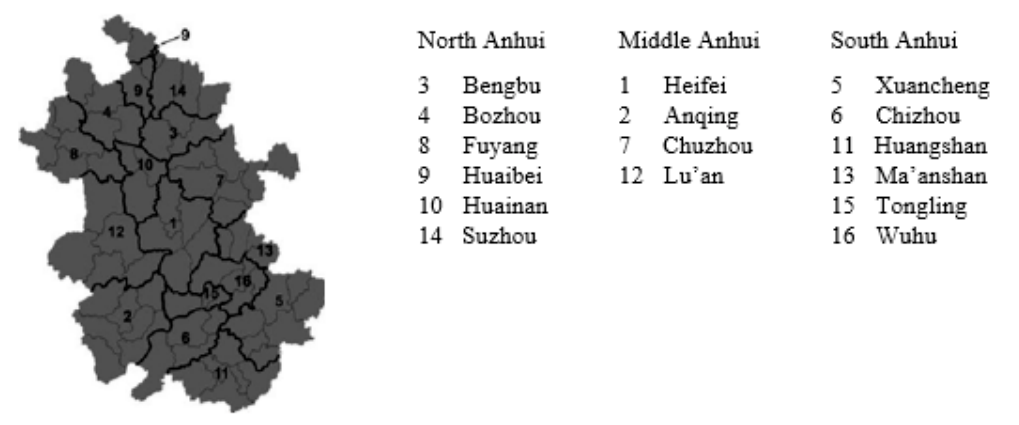
Figure 2. Urban distribution map of Anhui Province.